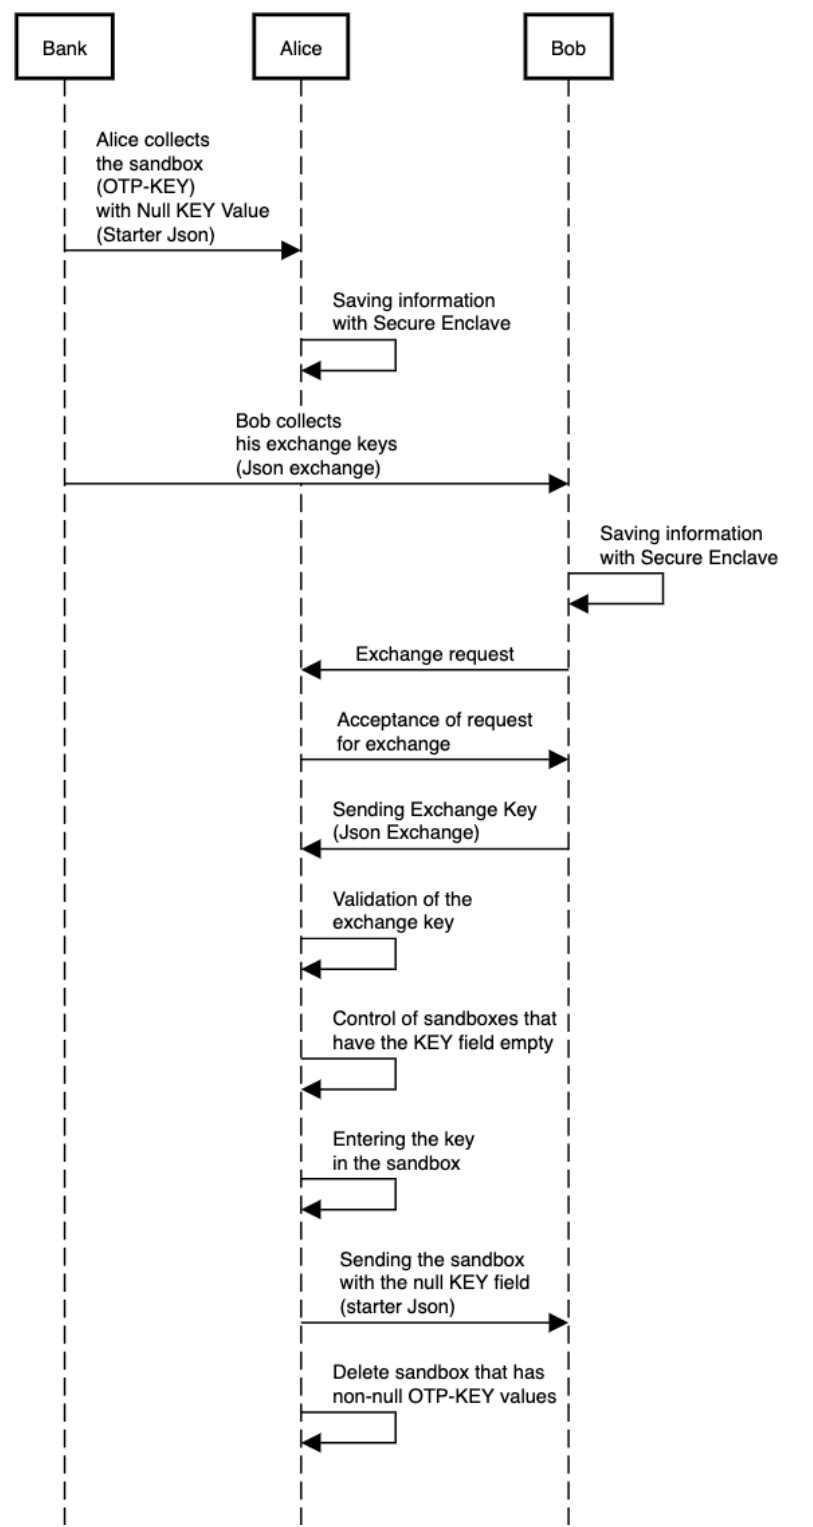
Figure 4. UML sequence diagram showing how the internal protocol